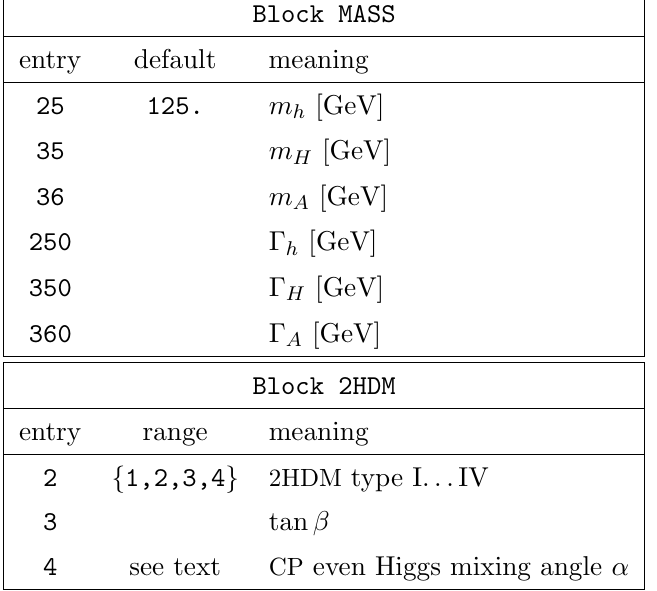
Table 12 . De(cid:12)ning the masses and widths of the light and heavy CP even Higgs h , H , and of the CP -odd Higgs A